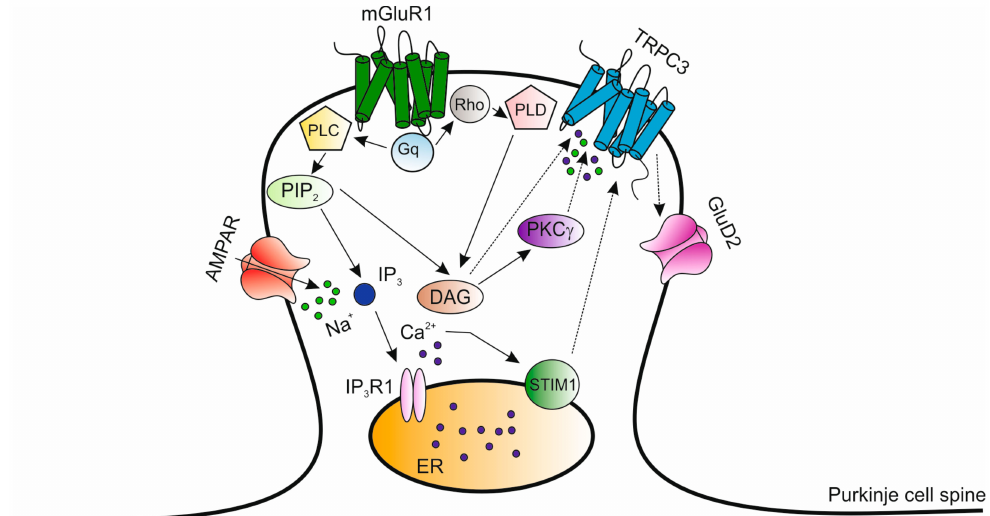
Figure 2. Subtype I metabotropic glutamate receptors-Transient Receptor Potential Canonical 3 (TRPC3)-PKC γ (mGluR1-TRPC3-PKC γ ) signaling at Purkinje cell synapse. TRPC3 channels and PKC